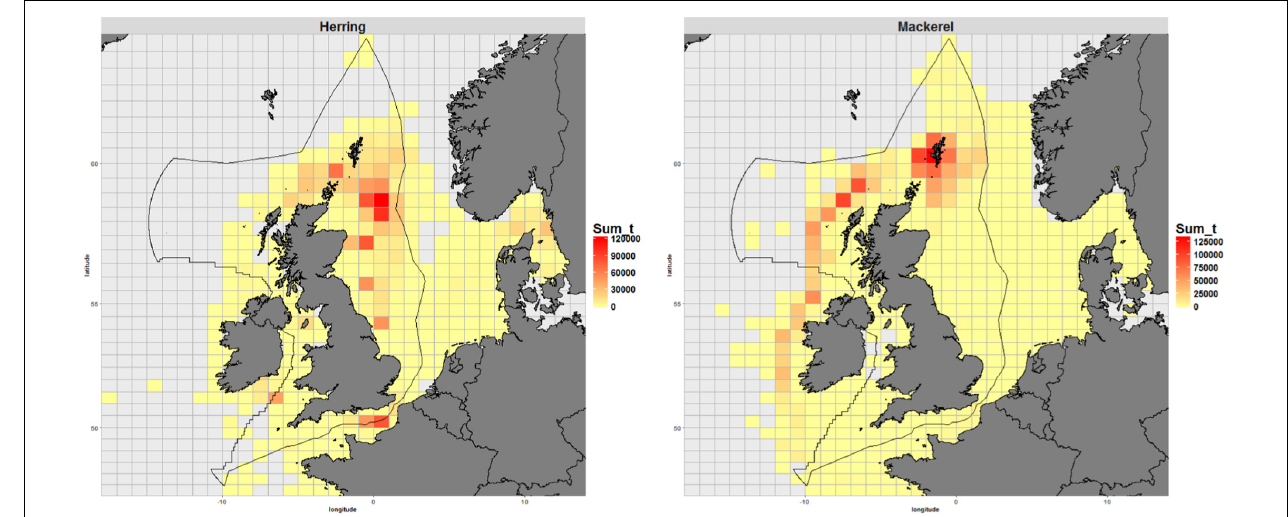
FIGURE 3 | Summed catch (t) from 2011 to 2015 for herring (left) and mackerel (right) from the EU fleet (Doering et al.,